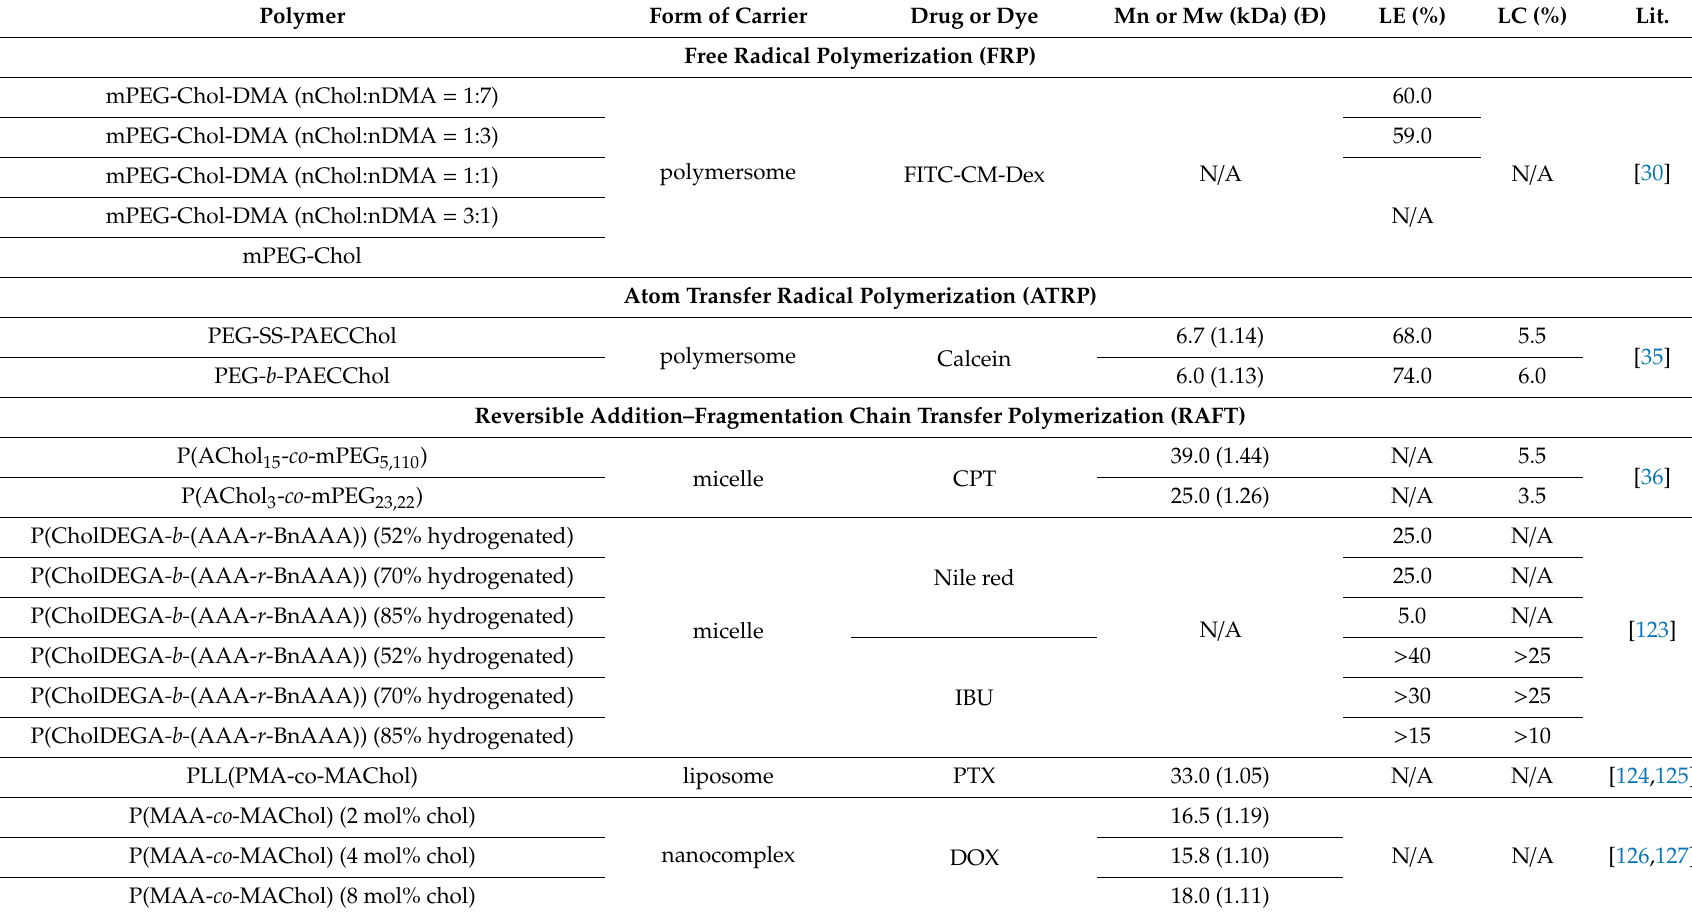
Table 3. Polymers bearing cholesterol in side chains reported as drug delivery